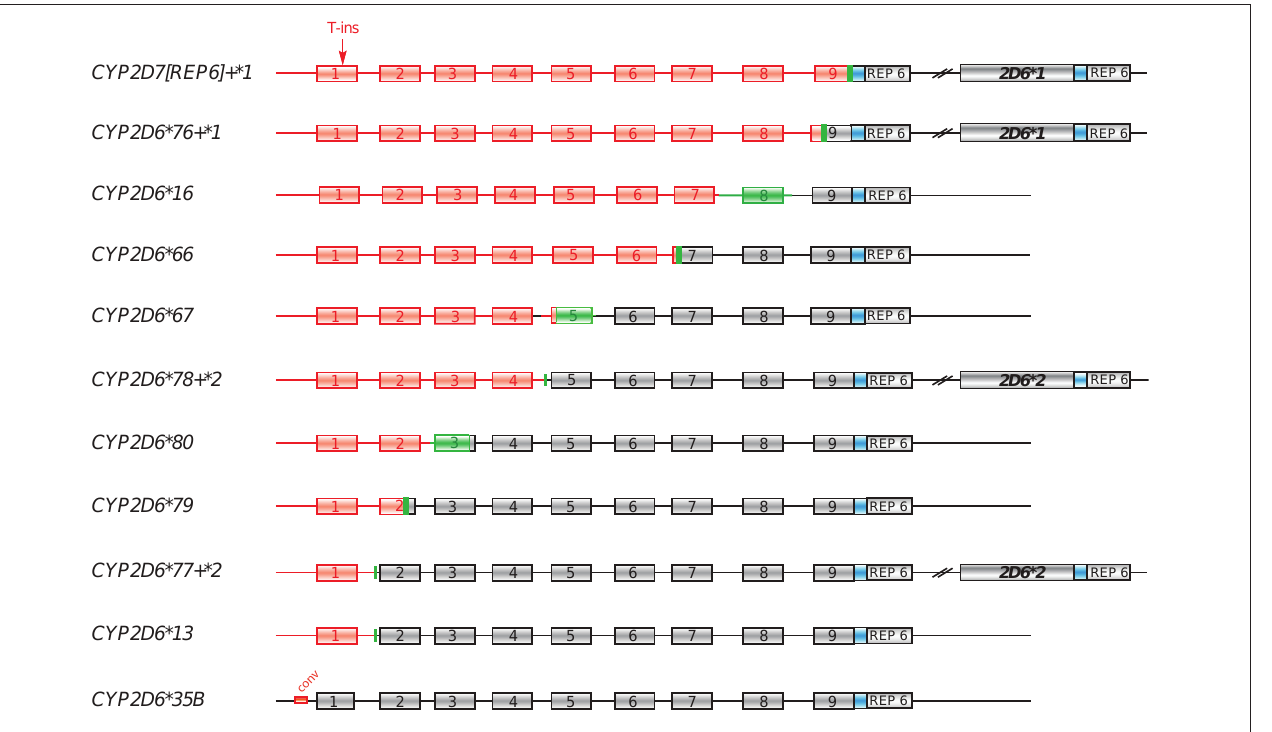
Figure 3 | graphic overview of hybrid alleles and their CYP2D7/2D6 switch region. CYP2D7 and CYP2D6 portions are shown in red and gray boxes, respectively. The CYP2D7 conversion in CYP2D6 * 35[variant] is shown as a red box upstream of exon 1. Switch regions are indicated in green. The red arrow notes a T-insertion in CYP2D7 exon 1 relative to CYP2D6 . The hybrid sequences were